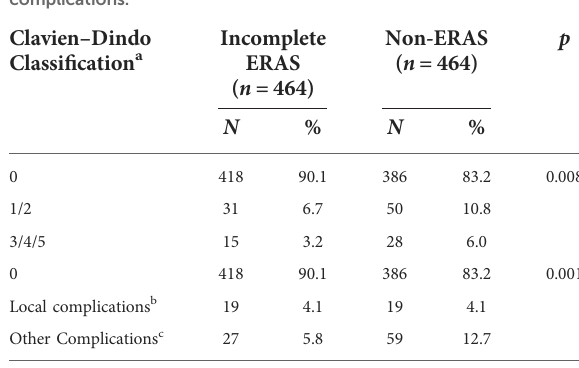
TABLE 3 Characteristics of the patients after matching according to treatment group.